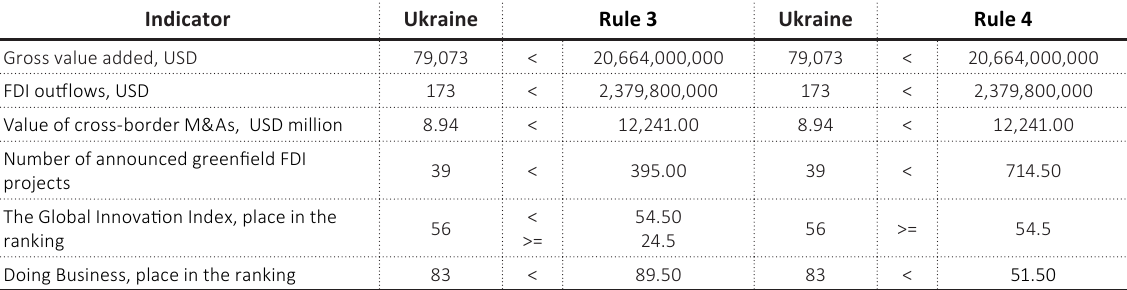
Table 3. The rules of a country’s belonging to the 2 nd cluster in comparison with real values for Ukraine in